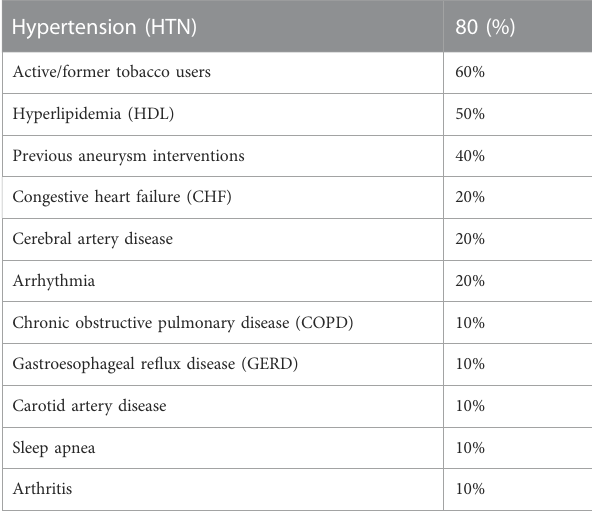
TABLE 1 Percentage of patients with